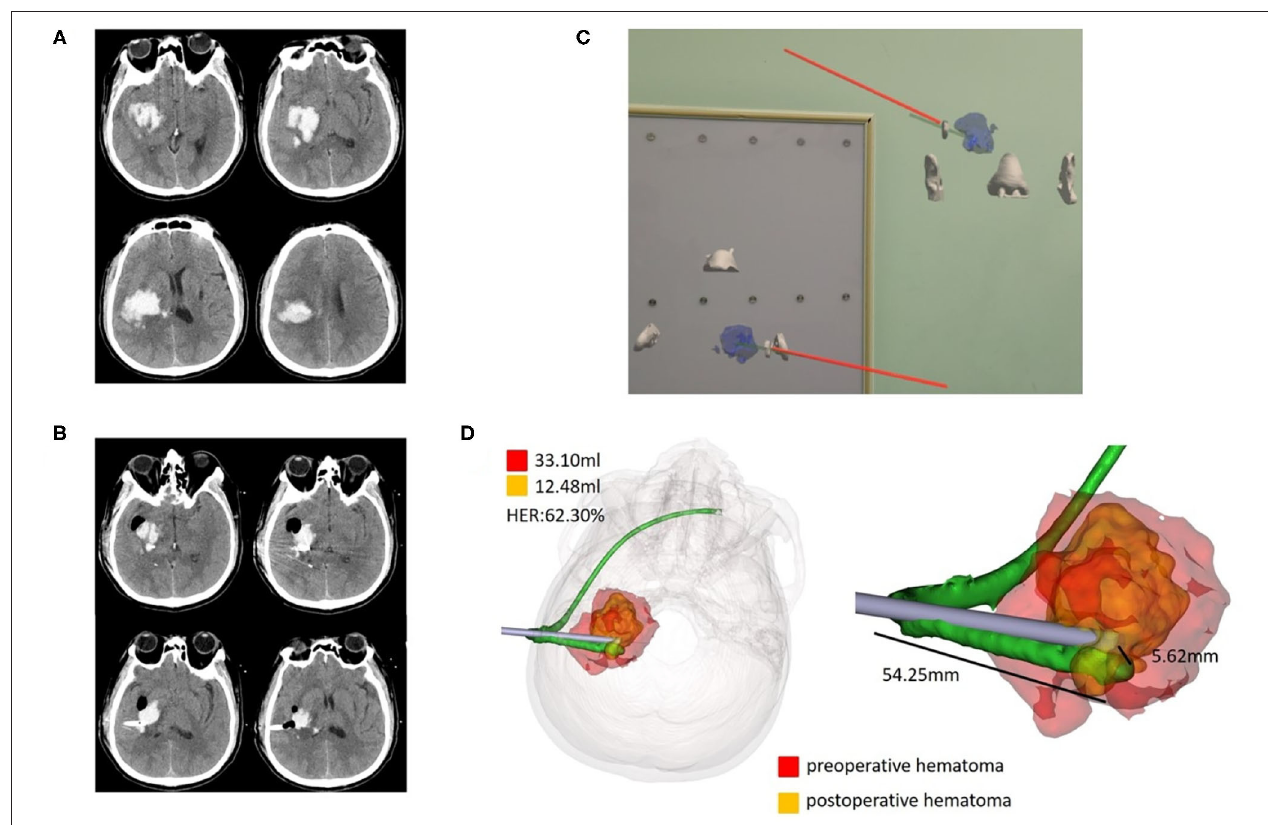
FIGURE 4 | Case 2, a 47-year-old male patient diagnosed with HICH in the right basal ganglia. (A) Preoperative CT showed HICH in the right basal ganglia. (B) Postoperative follow-up CT. (C) Wearing HoloLens, adjust the coronal, and horizontal planes for puncture through the ear and nose location. (D) Fusion of the preoperative and postoperative three-dimensional reconstructions of the hematoma. The preoperative hematoma volume was 33.10 ml, the postoperative hematoma volume was 12.48 ml, and the hematoma evacuation rate was 62.30 % . The length of the intracranial drainage tube was 54.25 mm, and the deviation of the drainage tube target was 5.62 mm. HER, hematoma evacuation